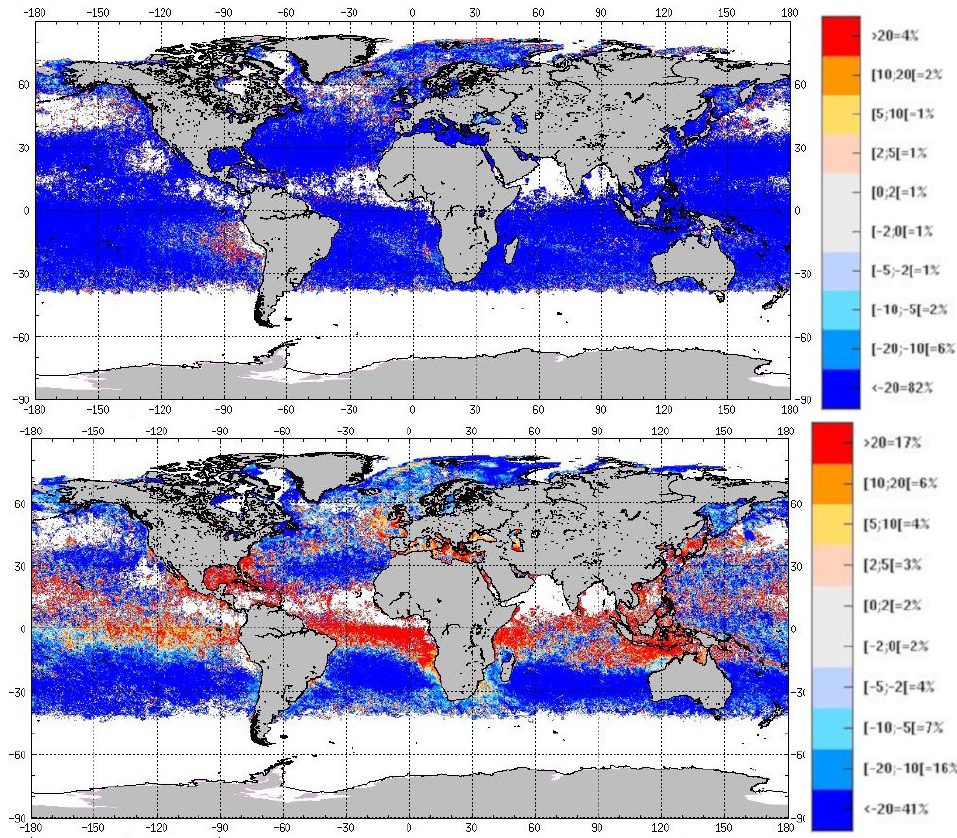
Figure 5. Relative difference between sensors [(S1 − S2) / S2] regarding monthly RRS (June 2018), for (top) MODIS Rrs(667) and OLCI Rrs(665) and (bottom) VIIRS Rrs(671) and MODIS Rrs(667). Source: these plots are part of the monitoring carried out by the OCTAC and reported on